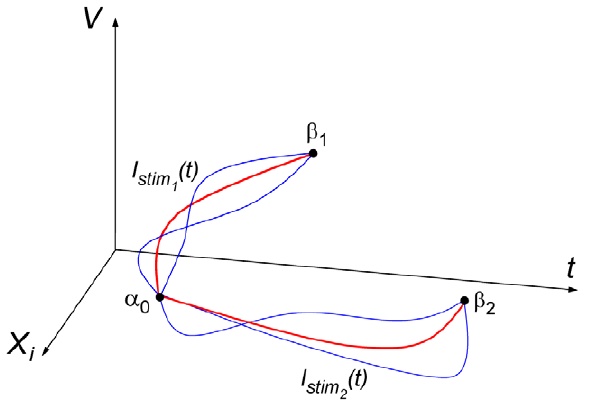
Figure 1. Explanatory diagram of the effect of current stimulations on trajectories of neuronal variables V , membrane potential, and the neuron’s i th state variable, X i , such as one of the ion channel gating parameters. Stimulation trajectories I stim 1 induce a state change from rest a 0 to threshold b 1 by means of depolarization, and stimulation curves I stim 2 induce a state change to b 2 by means of post-inhibitory rebound. Red trajectories illustrate the optimal paths for which total current is minimized; blue trajectories are neighboring paths of suboptimal stimulation.